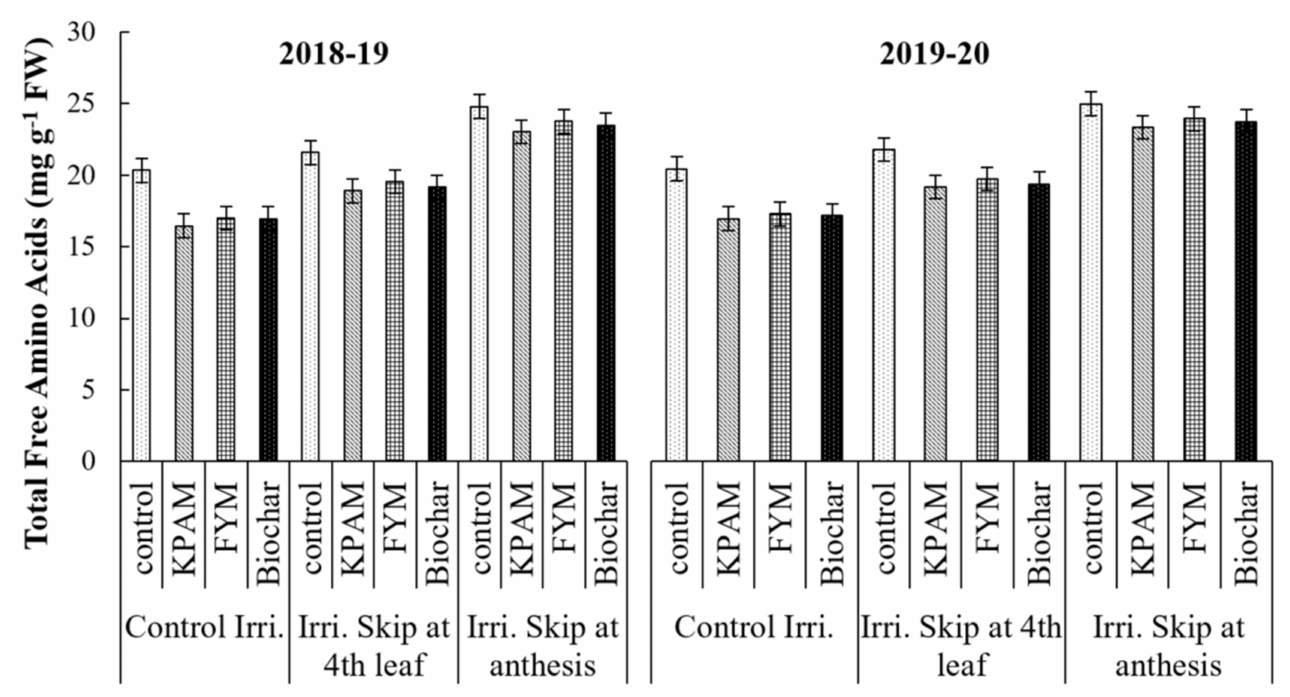
Figure 9. Effect of soil amendment materials on total soluble sugars in the wheat crops grown under normal and water stress imposed by skipping irrigation at 4th leaf and anthesis stage of growth (mean values ± S.E).